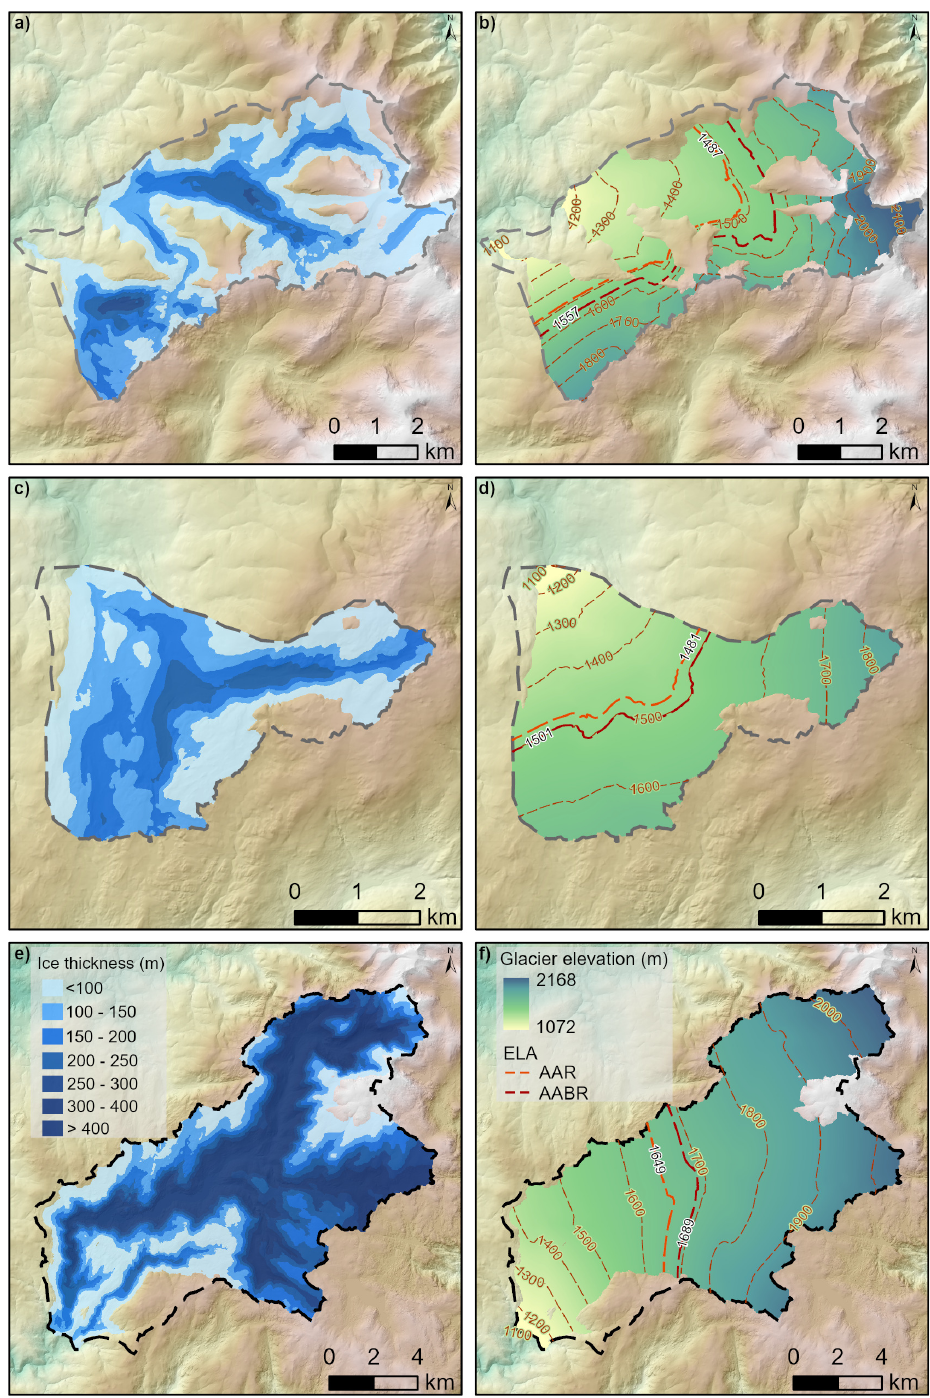
Figure 10. Paleoglaciers’ characteristics. ( a , c , e ) represent the ice thickness in Xares, Canda, and Bibei-Barxacova, respectively; ( b , d , f ) paleoglacier elevation in Xares, Canda, and Bibei-Barxacova, respectively. The ELA was estimated with a 0.67 ratio for AAR and 1.75 for the AABR